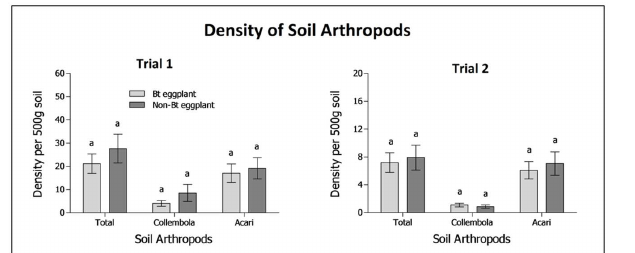
Fig 4. Species density of arthropods in the soil planted to Bt and non-Bt eggplants. Trials 1 and 2, CY 2010–2011. Common letters above the bars indicate no significant differences among the densities. Note different scales on